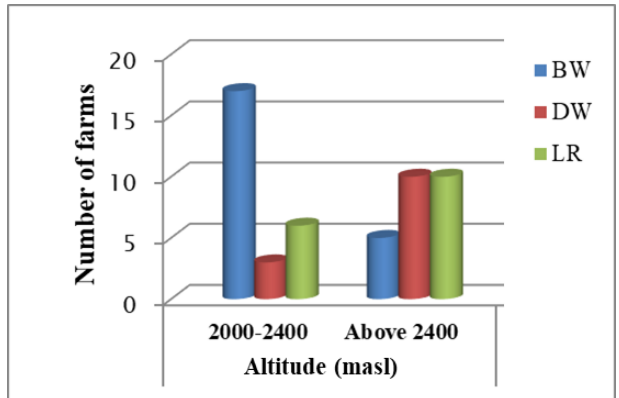
Figure 2. The number of tetraploid wheat (DW), local landraces (LR) and modern wheat varieties (BW) grown in different altitude zones based on direct field observations in